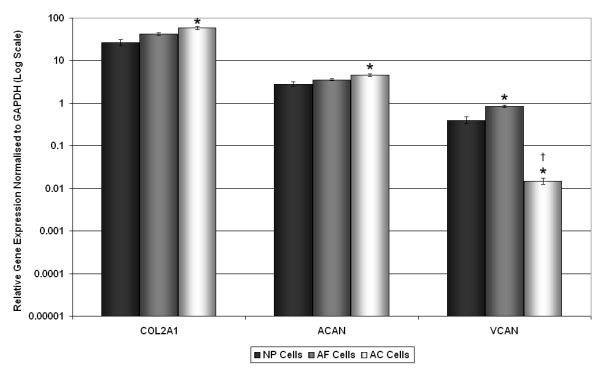
Quantitative real-time PCR for typical chondrocyte marker genes in bovine AC, AF and NP cells. Relative gene expression for the chondrocyte marker genes (type II collagen (COL2A1), aggrecan (ACAN) and versican (VCAN)) was normalised to the housekeeping gene, glyceraldehyde-3-phosphate dehydrogenase (GAPDH) and plotted on a log scale. * statistical significance between nucleus pulposus (NP) and annulus fibrosus (AF) cells and nucleus pulposus (NP) and AC cells (P < 0.05). † statistical significance between AF cells and AC cells (P < 0.05).